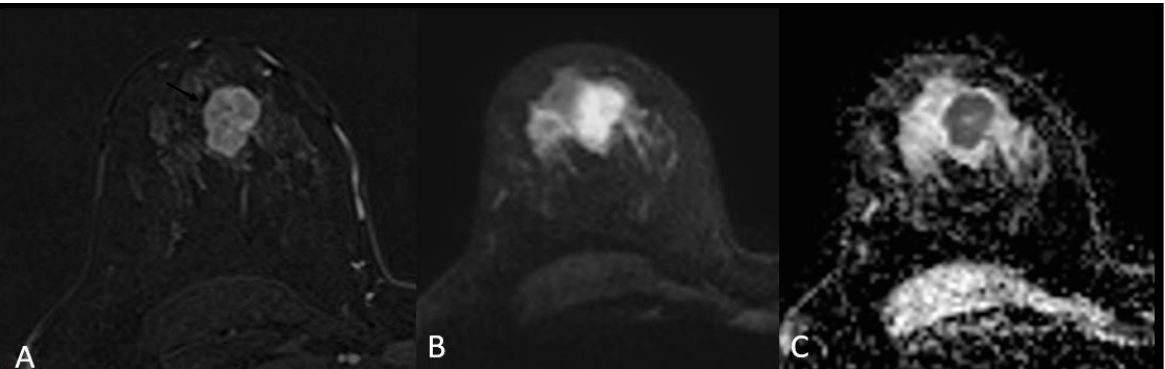
Figure 3. Triple negative breast cancer in a 33-year-old woman—subtracted T1-weighted contrast- enhanced image ( A ) shows a 3 cm oval (lobulated) mass with circumscribed margins, heterogeneous enhancement and restricted diffusion on DWI ( B ) and ADC ( C ).